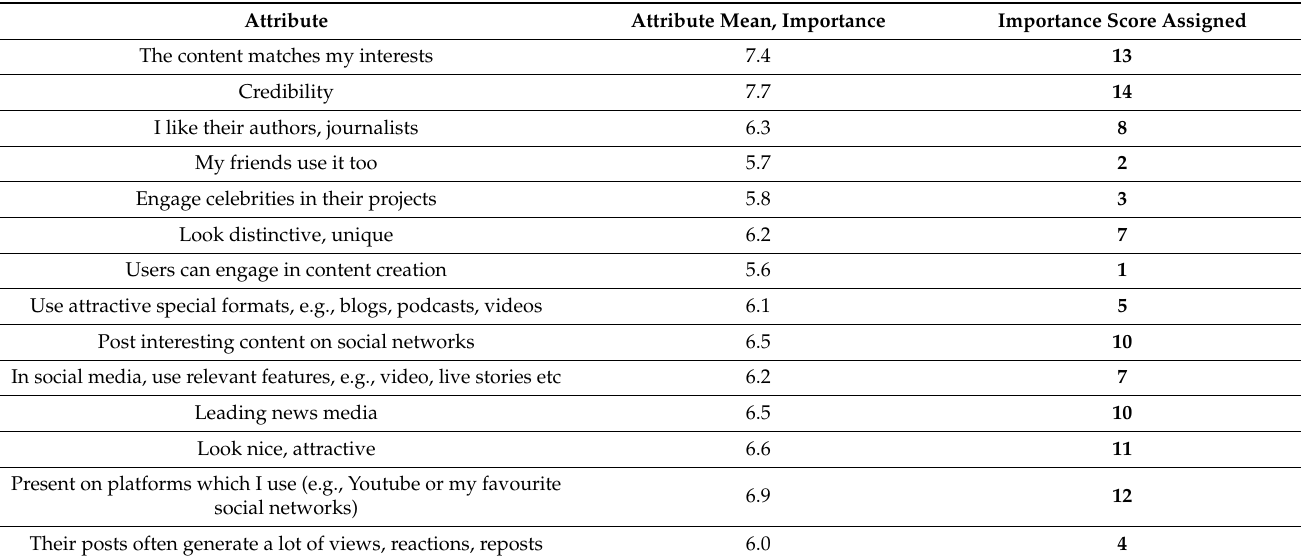
Table 9. The news media assigned attribute importance calculation ratings to 15- to 24-year-old audiences, Latvia,